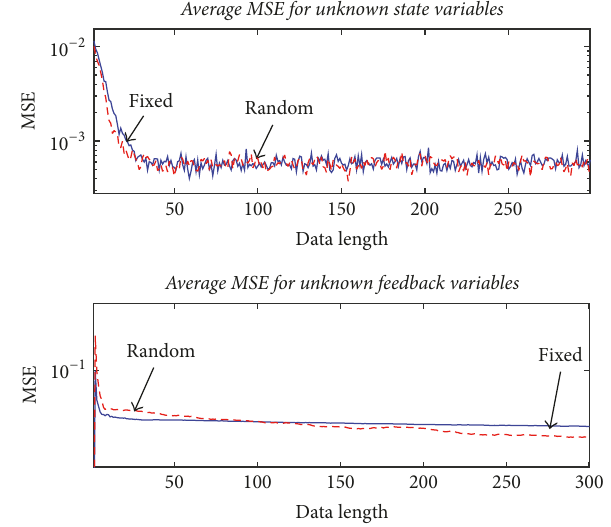
Figure 5: Estimation of the underlying vector of preferences and the feedback parameters when there is feedback. The results are averaged over 100 independent trials. Two different configurations are simulated for the feedback as well as for the linear control parameters,forexample,thefixedandrandominitialcases.Forboth scenarios, our estimation process converges to the true underlying